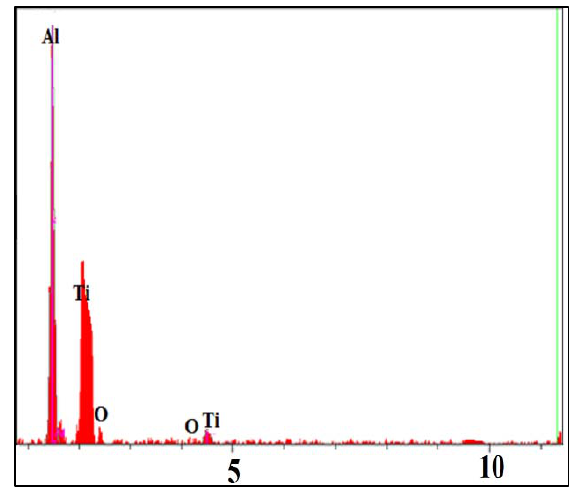
Fig 6. EDX pattern of the electrosynthesized polyaniline-TiO nanocomposite coated AA3004 for 2 15 mAcm -2 .